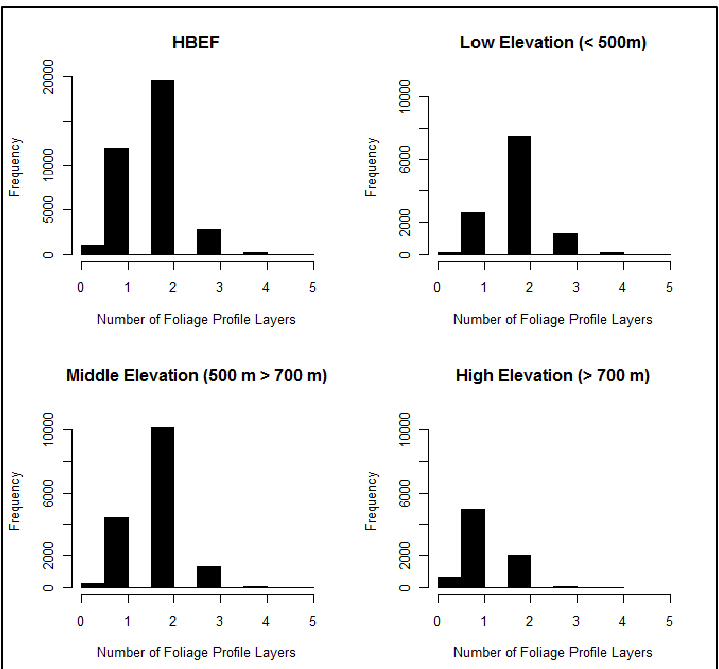
Figure 9. Histogram of number of foliage profile layers showing the number of pixels in each group of layers for all of HBEF (upper left) as well as at the low, middle, and high elevation